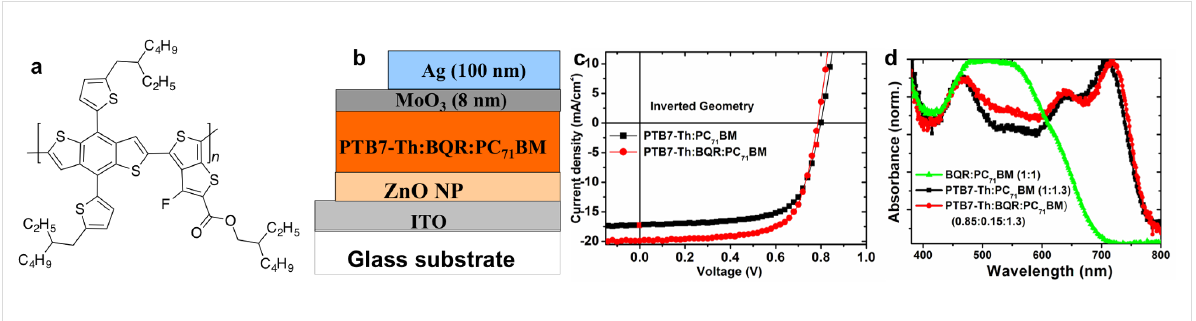
Figure 14: J–V characteristics of PTB7-Th : BQR : PC 71 BM ternary BHJ solar cells. (a) PTB7-Th chemical structure, (b) inverted device architecture, and (c) J–V curve for BQR containing ternary device, and (d) UV–vis absorption spectra of ternary and binary blend active layers BQR : PC 71 BM , PTB7-Th : PC 71 BM and PTB7-Th : BQR : PC 71 BM .